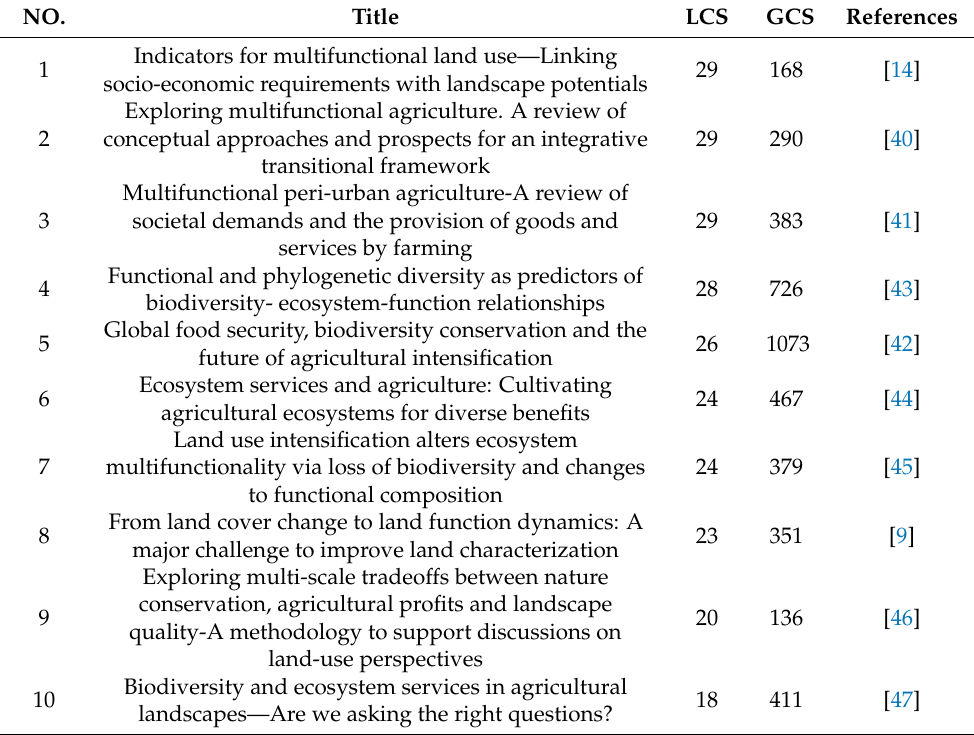
Table 1. The top 10 LCS papers in terms of agricultural land function.